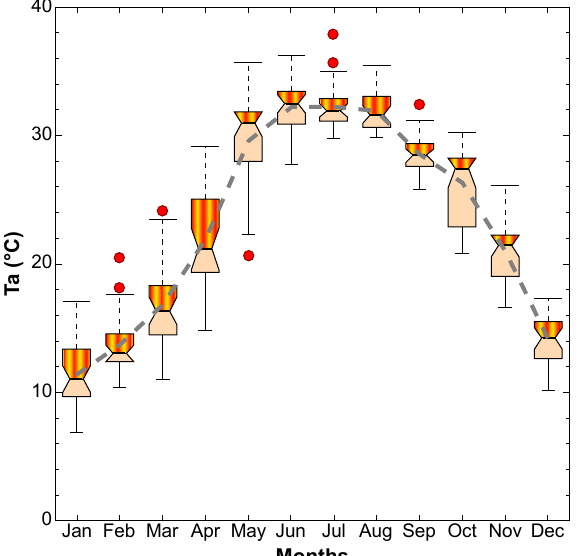
Figure A2. Notched boxplots show the daily variability of DHI for each month; the dashed line shows the mean values.